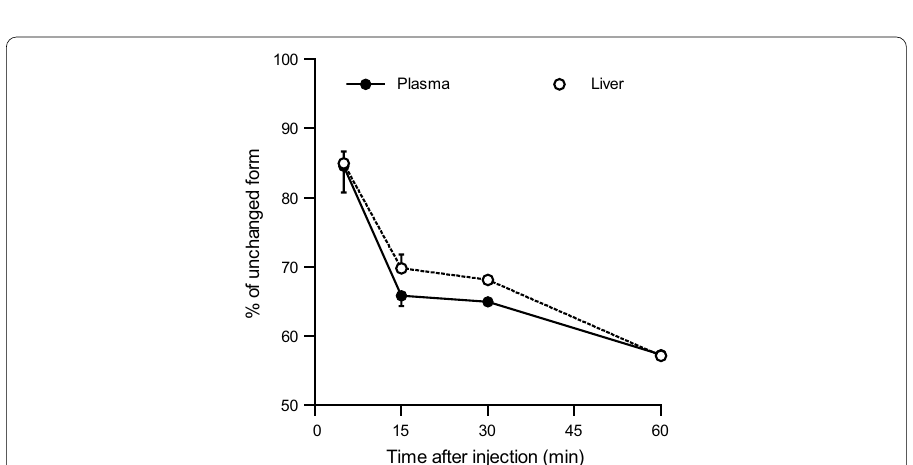
Fig. 5 Unchanged form of [ 11 C]PK68 in the plasma and liver of a mouse at 5, 15, 30, and 60 min after injection (n =